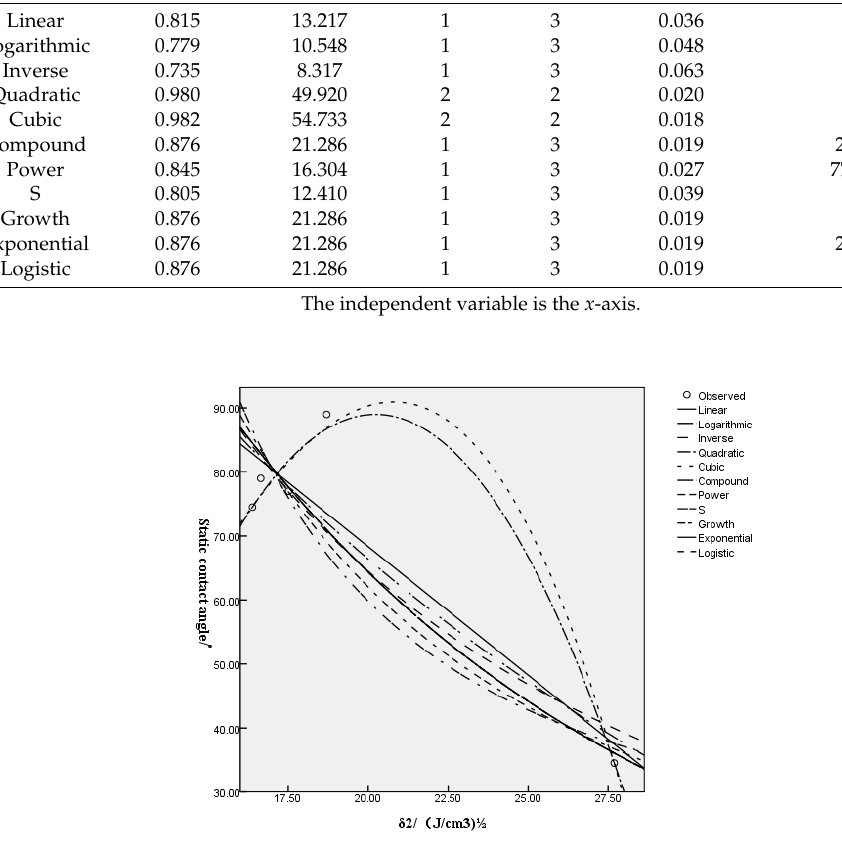
Figure A1. Model summary between tensile strength and the solubility parameter.